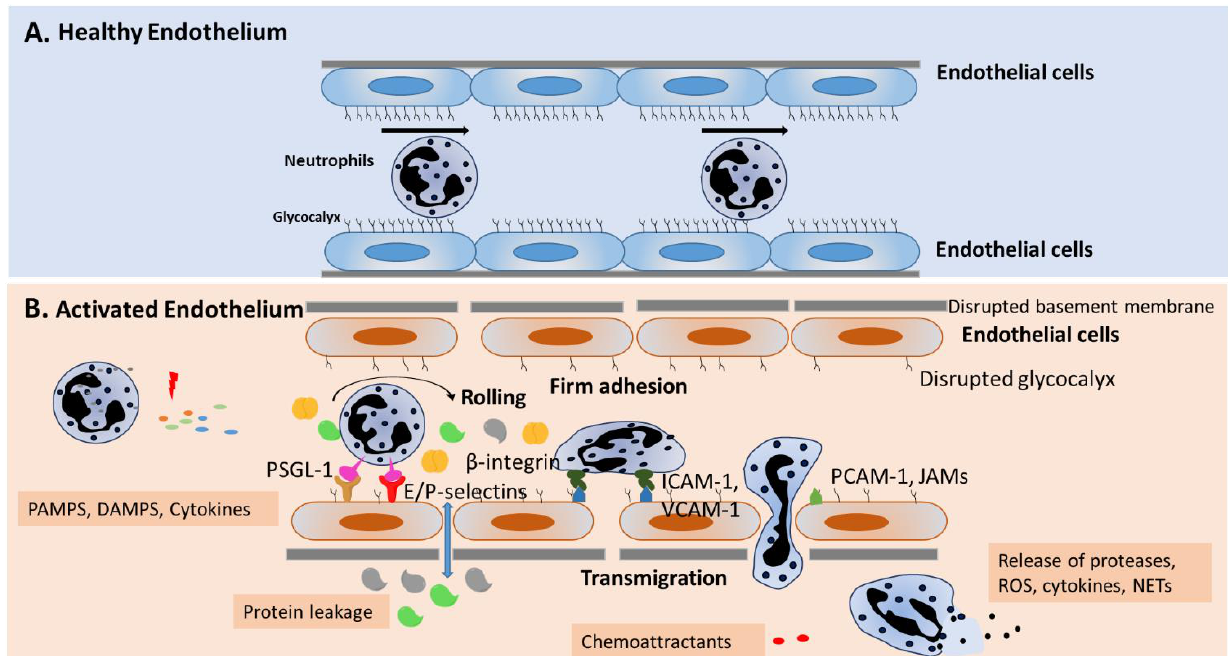
Figure 1. Endothelial cell activation in sepsis: increased barrier permeability and neutrophil migration: ( A ) Under normal conditions, the vascular endothelium is covered by the glycocalyx to form a tight barrier that regulates barrier permeability, neutrophil migration, and anti-inflammatory defenses. ( B ) During sepsis, PAMPS and DAMPS activate neutrophils and endothelial cells to produce cytokines and chemoattractants, which activate neutrophils to display surface molecules that interact with adhesion molecules expressed by activated endothelium. The rolling step involves interactions of E/P-selectin and their ligand (e.g., PSGL-1) on neutrophils, which slows down the neutrophil. The next step, firm adhesion, is mediated by adhesion molecules of endothelium, including ICAM-1, ICAM-2, and VCAM-1, and their neutrophil ligands, β 2 integrins. In response to chemoattractants, adhered neutrophils migrate through endothelial junctions, involving PECAM-1 and JAMs. Activated neutrophils release cytokines, ROS, and proteases, or undergo NETs formation. During sepsis, the glycocalyx is degraded, endothelial cell tight junctions are damaged, and there is increased endothelial cell apoptosis, leading to damaged barrier function and increased